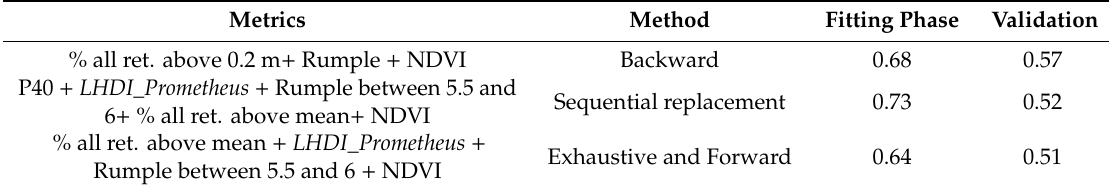
Table 5. Overall accuracy of All subsect selection ALS and Sentinel 2 selected metrics using SVMr classification method.